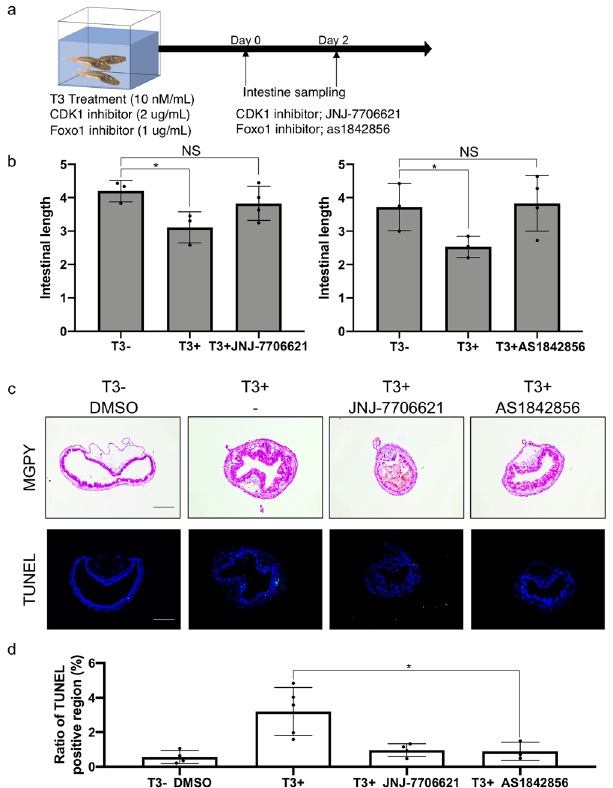
Fig. 7 Inhibiting CDK1 signaling blocks intestinal remodeling during T3- induced metamorphosis. a Experimental design for treatment with CDK1 and Foxo1 inhibitors. Wild-type tadpoles at stage 54 were treated with 2 μ g/ml of CDK1 inhibitor JNJ-7706621 or 1 μ g/ml of phosphorylation inhibitor of Foxo1 as1842856 for 2 days in the presence and absence of T3. Most of tadpoles treated with the inhibitors in the presence of T3 died at 3 days. Thus, intestinal remodeling was analyzed after 2 days of T3 treatment. b JNJ-7706621 and as1842856 inhibits T3-induced shortening of the intestine. Tadpoles at stage 54 were treated with or without 10 nM T3 for 2 days in the presence or absence of indicated inhibitor. Intestinal length was measured from bile duct junction to colon and normalized against body length. Each group included more than 4 tadpoles. Each bar represents the mean plus S.E. The asterisk (*) indicates a signi fi cant difference between the T3 treated tadpoles and control animals ( P < 0.05) (see Supplementary Data 21 for raw data). c T3-induced intestinal morphological changes (epithelial folding) and apoptosis in the intestinal epithelium were inhibited by JNJ-7706621 and as1842856. Tadpoles were treated as above. Cross-sections of the intestine were stained with MGPY, which stains DNA blue and RNA red (top), and apoptotic cells were detected by TUNEL staining (bottom). TUNEL positive cells were stained green and nuclei were stained by Hoechst 33342 (blue). Bar indicates 20 μ m (see Supplementary Data 21 for raw data). d Quanti fi cation of the apoptotic cells in c . TUNEL positive epithelium region was measured by using ImageJ software and normalized against the total epithelium region as determined by DAPI staining (see Supplementary Data 22 for raw those present only in the wild-type intestine in Supplementary Data 13, 14). Second, TR α knockout dramatically inhibited T3- induced larval epithelial cell death and adult epithelial cell pro- liferation in the intestine 19 , suggesting that TR α -dependent acti- vation of the cell cycle/proliferation program is, surprisingly, important for larval epithelial cell death in addition to its likely involvement in subsequent adult epithelial stem cells proliferation.